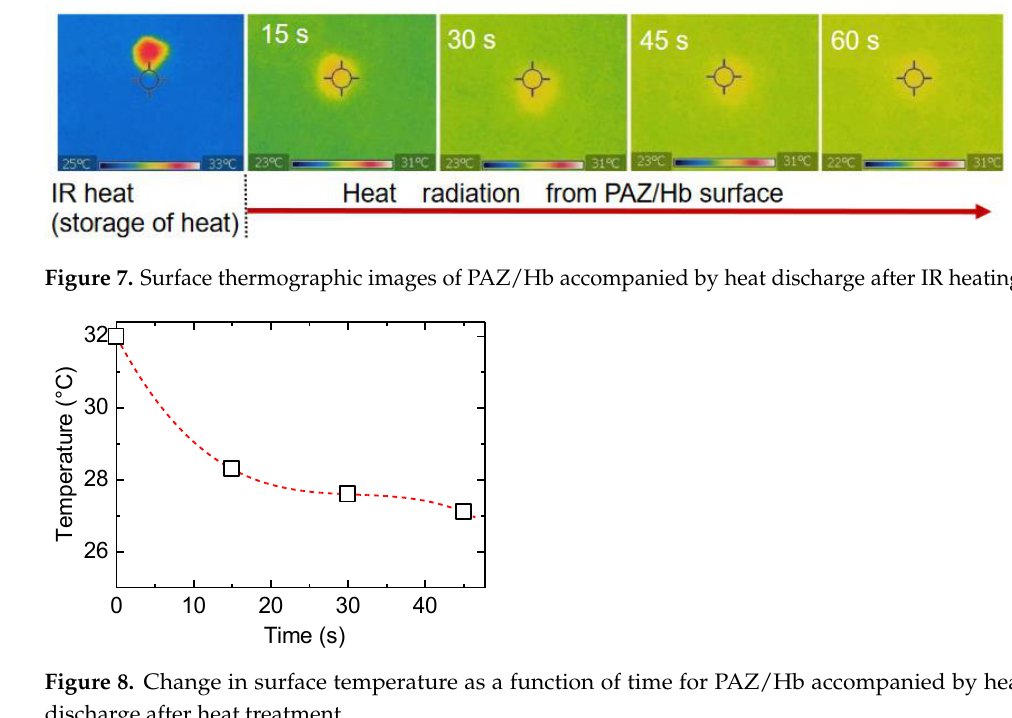
Figure 6. 1/ R ( σ) as a function of the temperature of PAZ/Hb ( a ). Resistance vs. 1/ T 1/4 as a Mott plot ( b ) for PAZ/Hb.